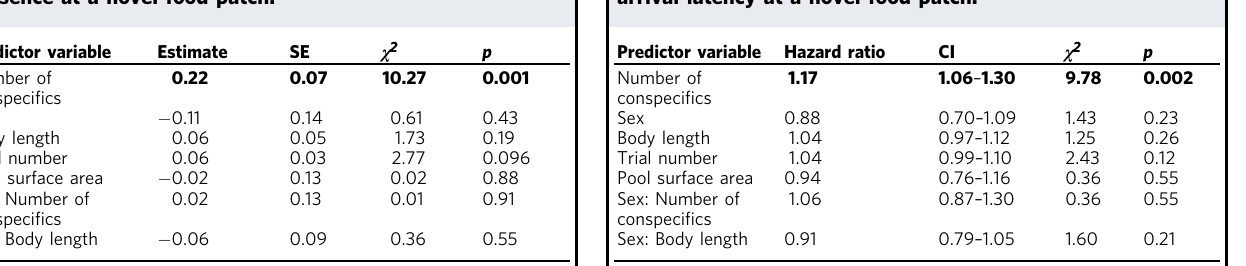
Table 1 Generalized linear mixed model summary for presence at a novel food patch.